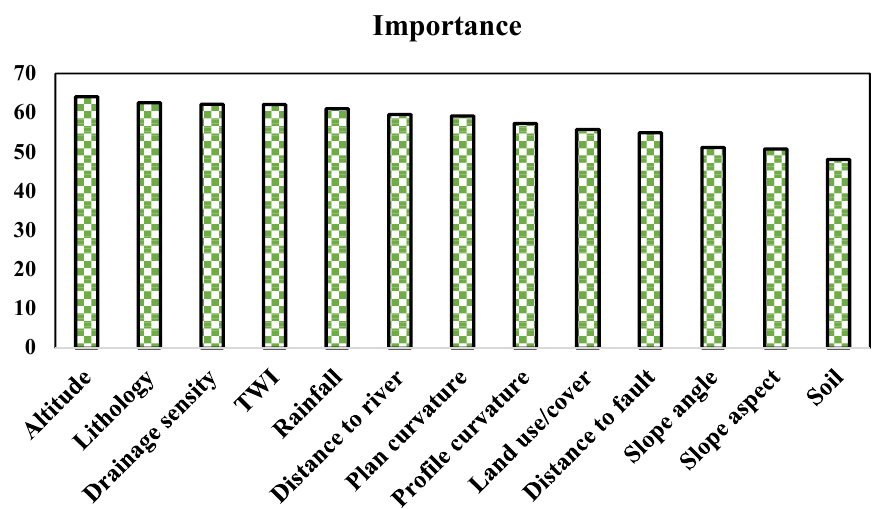
Figure 5. The importance of the effective criteria determined using the OneR technique.